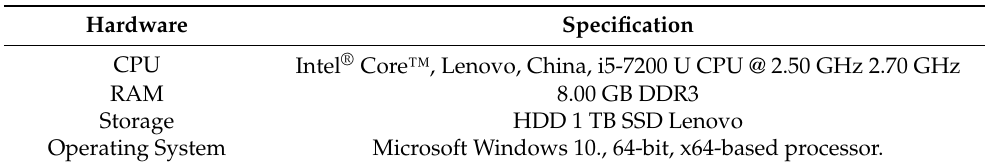
Table 2. Hardware specifications of the device used for the simulation.